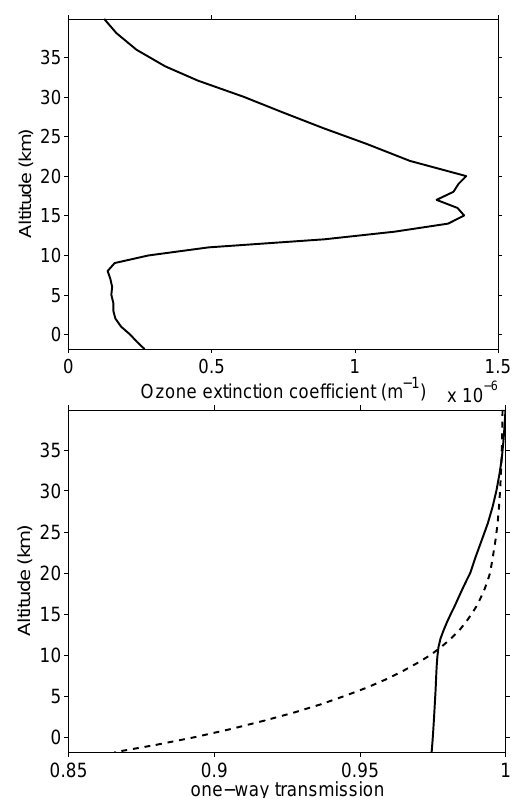
Fig. 2. Extinction (top) and one-way transmission (bottom) for ozone (solid line) and a reference molecular profile (dashed line) at 532nm